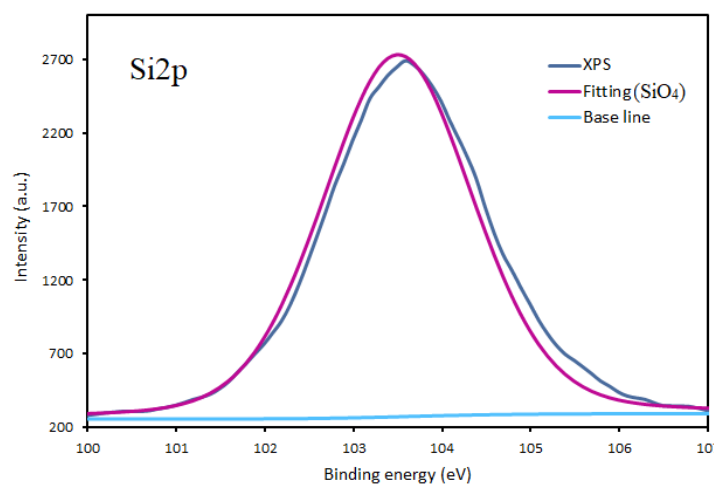
Figure 5. Fitting of Si2p peak of the thin film deposited onto titanium substrates by DC plasma jet in condition A.